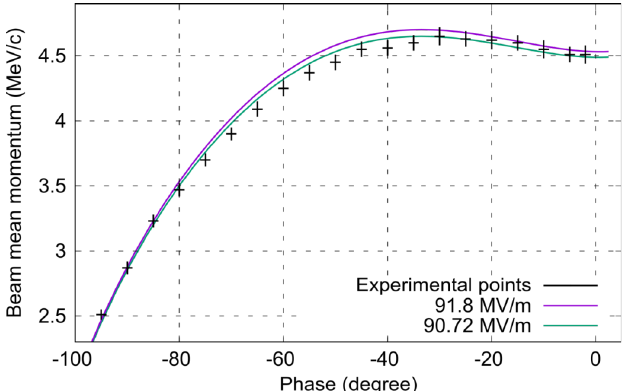
Figure 8. Measured beam momentum vs. RF phase. The acceleration gradient is estimated with around 91MV/m from fitting ASTRA